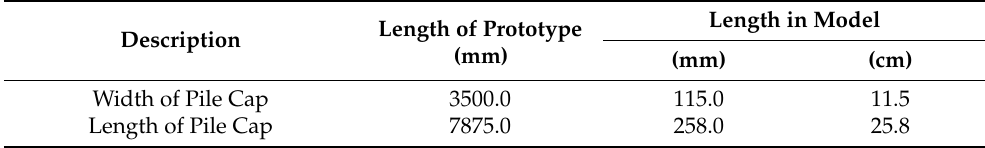
Table 2. Scale down values of different members of bridge pier